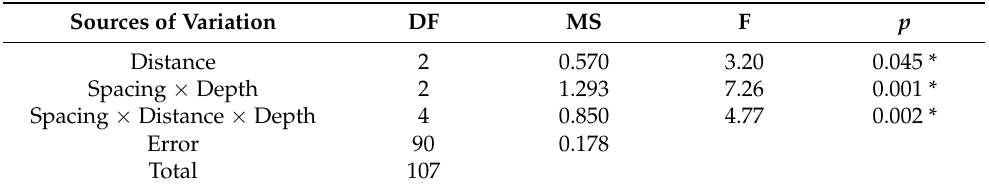
Table 2. ANOVA results for the effects of spacing, distance from the tree, and soil depth on root dry mass of E. camaldulensis intercropped with rice at the age of 7 years.